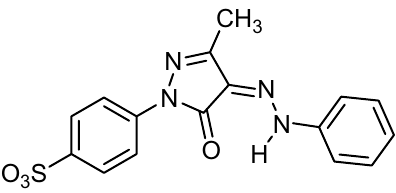
Figure 1. Chemical structure of AY11 dye (MF: C 16 H 13 N 4 NaO 4 S) (MW: 380.35 g/mol) (C.I.18820) (Other names: Acid Yellow G, Acid Brilliant Yellow 2R, Acid Brilliant Yellow G) (CAS number: